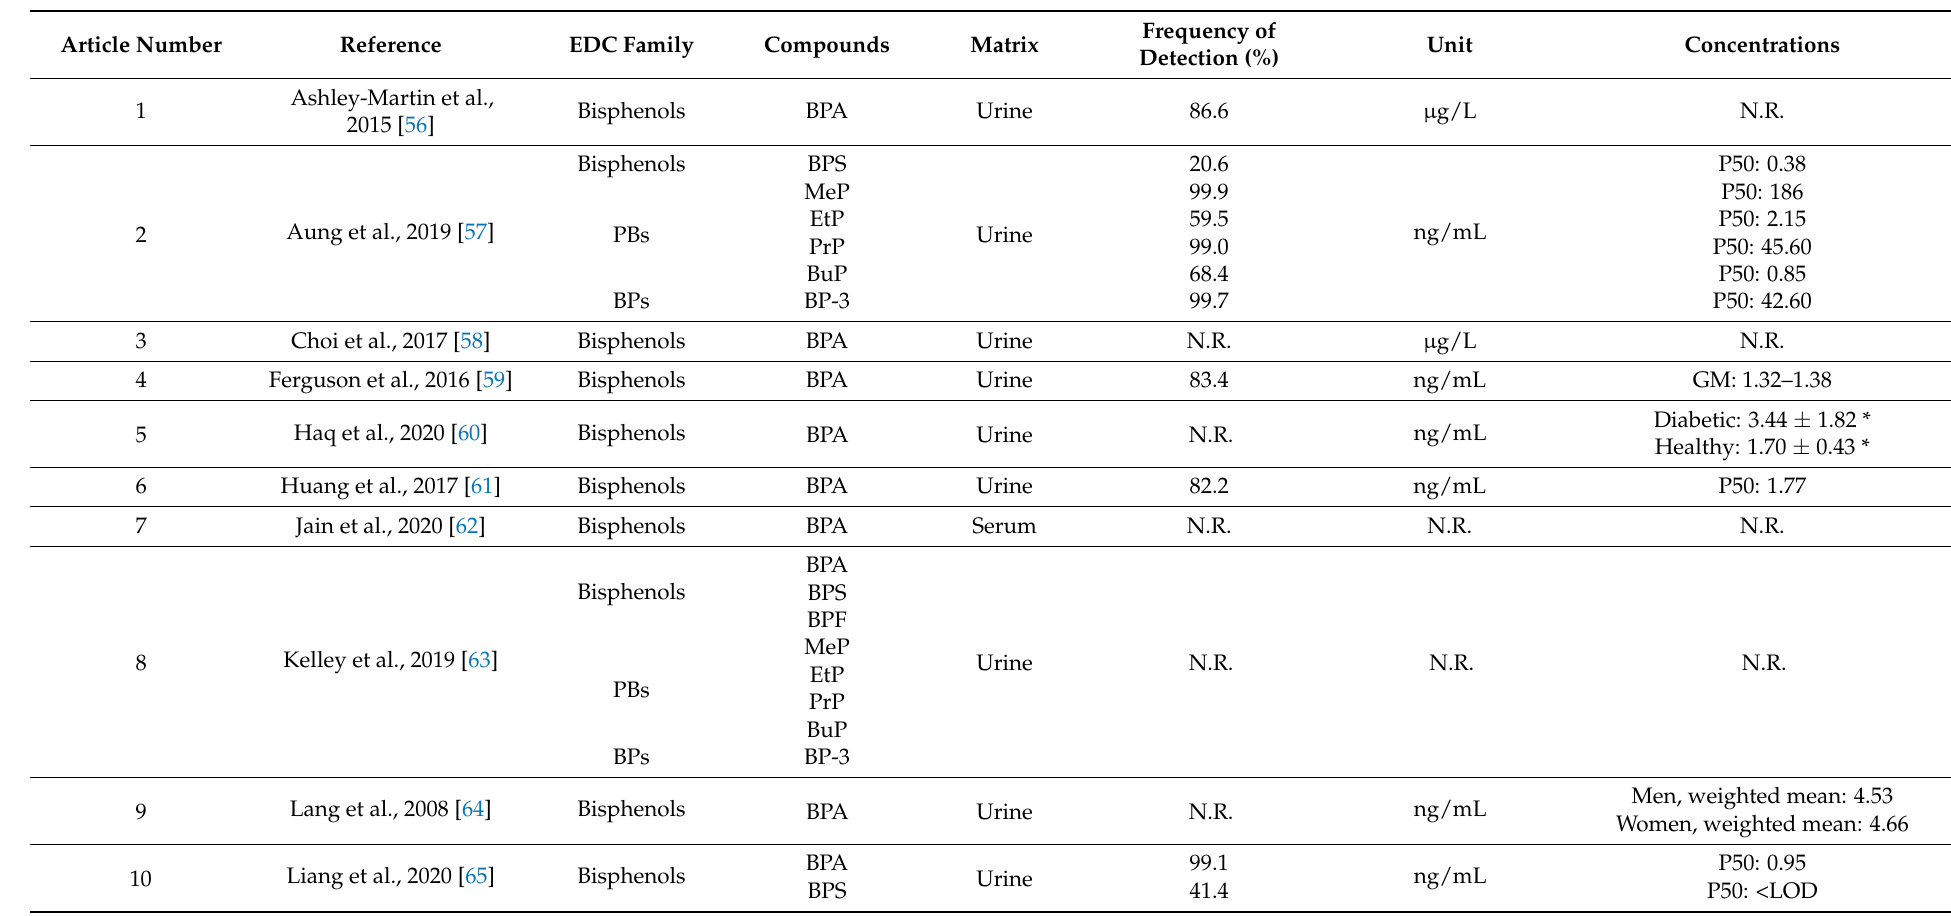
Table 2. Characteristics related to the exposure assessment to bisphenols, PBs, and BPs in the selected